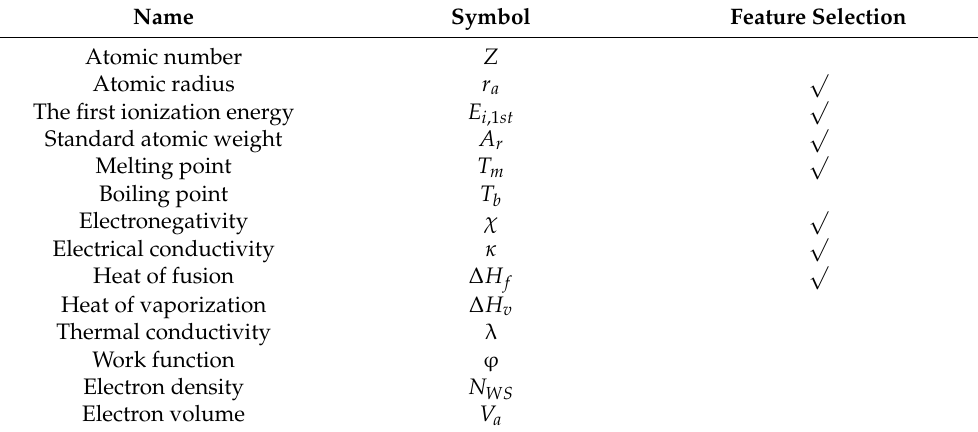
Table 1. Intrinsic properties of elements and symbolic